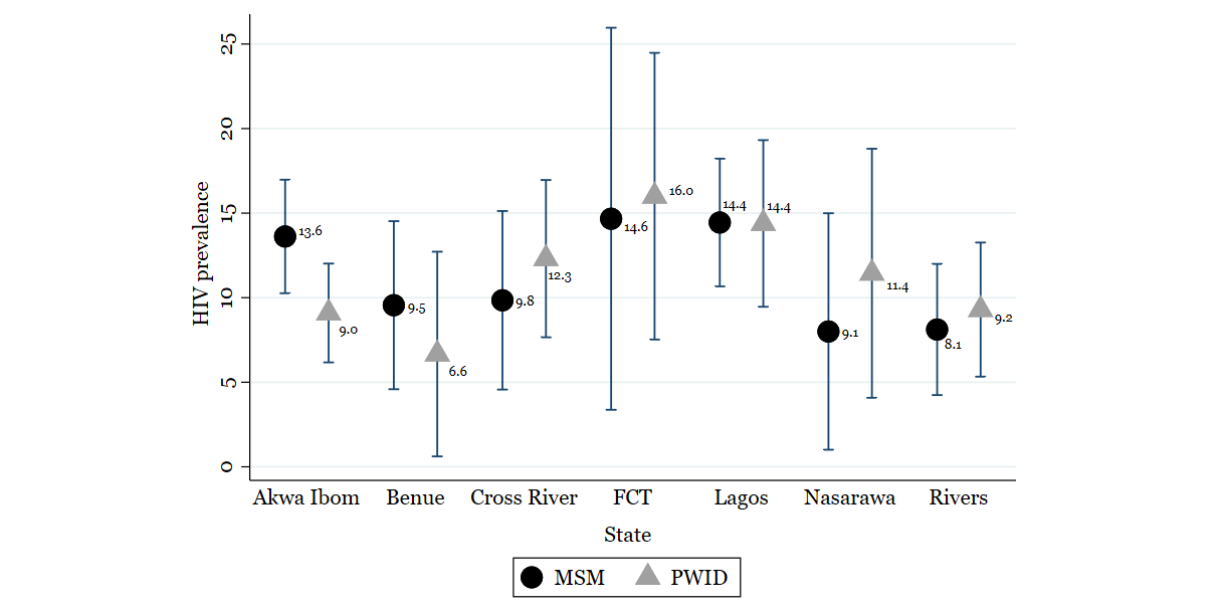
Figure 1. HIV seroprevalence among MSM and PWID by state, September 30, 2017. Mean HIV seroprevalence with 95% CIs. FCT: Federal Capital Territory; MSM: men who have sex with men; PWID: people who inject